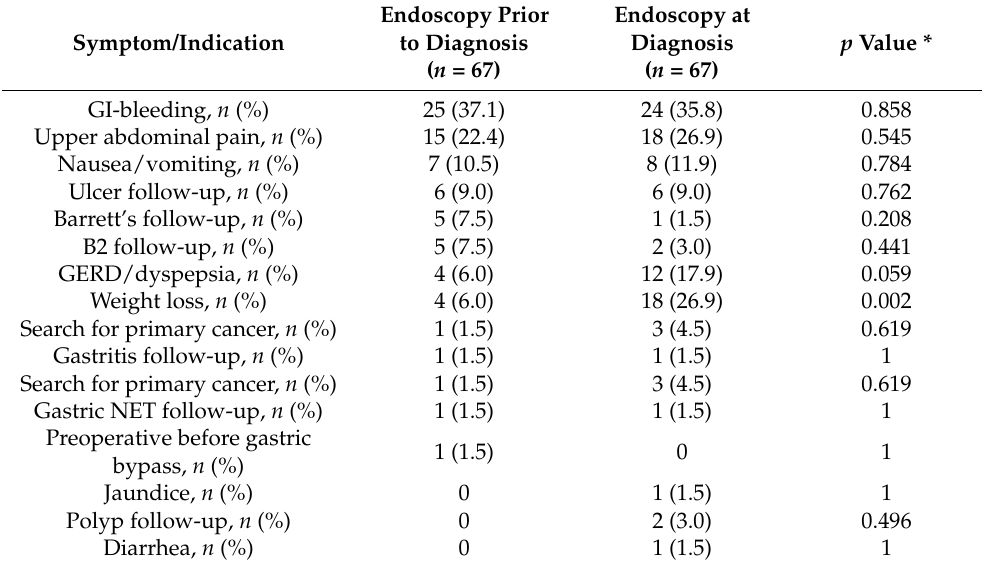
Table 3. Symptoms or indication for upper endoscopy prior to the diagnosis of gastric cancer versus at the time of diagnosis in 67 patients with missed gastric cancer at the first